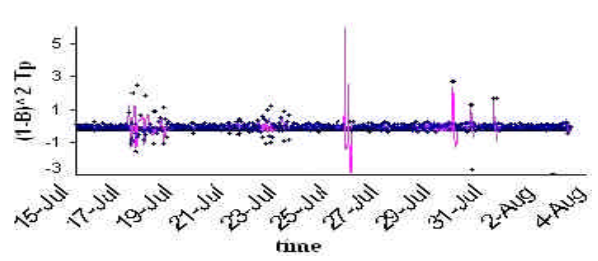
Figure17. Predicted (solid line) and measured (dotted line) (1-B) 2 Tp Fig. 17. Predicted (solid line) and measured (dotted line) (1 − B) 2